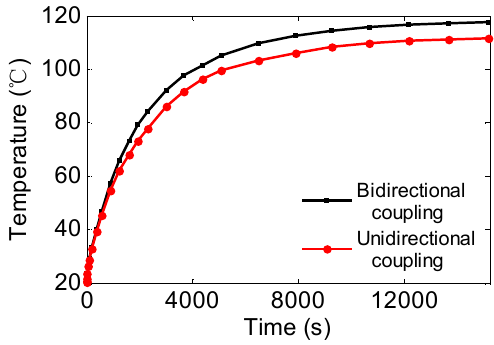
Figure 16. The temperature rise of the stator core.